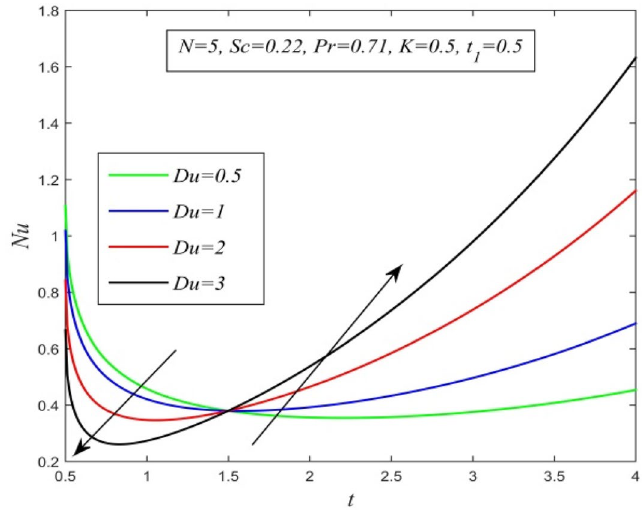
Figure 25. Nu versus t for different Du and Sc = 0.22, N = 5, Pr = 0.71, K = 0.5, t 1 = 0.5.